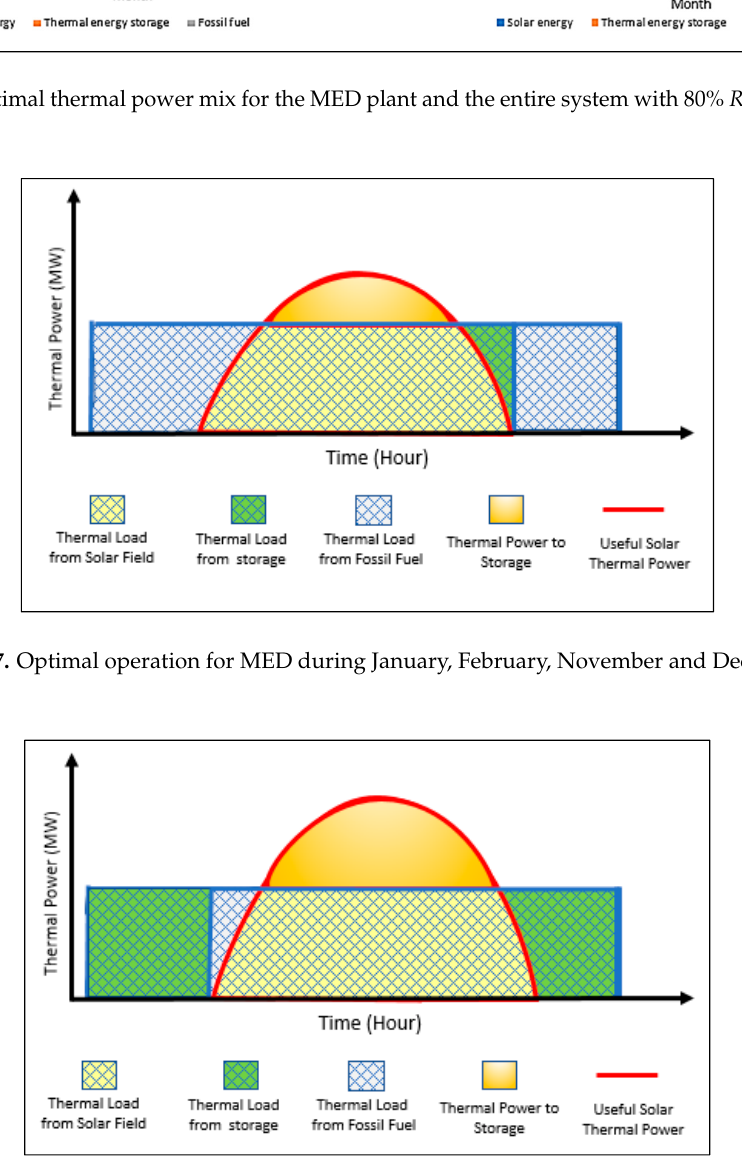
Figure 8. Optimal operation for MED during April, March, May, June, July, August, December and October.